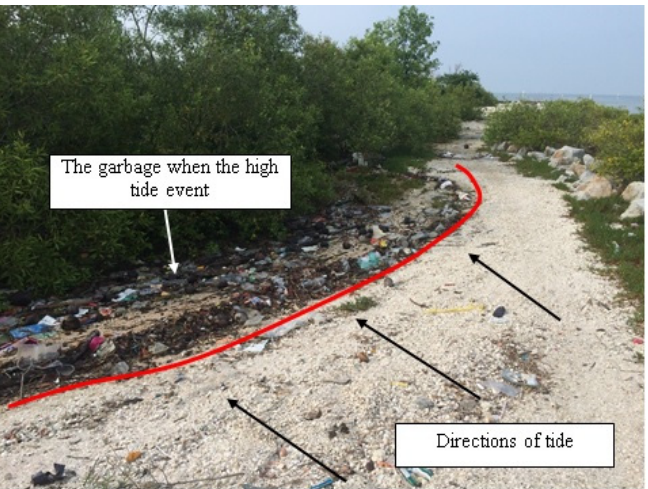
Figure 5. Photo showing the accumulation of garbage as the high tide occurred at Sungai Pulai (2017). Red line indicating erosion along the shoreline.